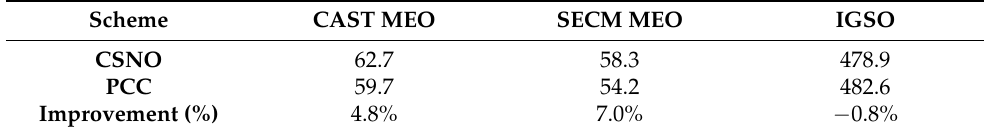
Figure 12. The time series of the differences of the CSNO Scheme IGSO orbit compared with the WUM products in along-track (A), cross-track (C), radial (R), and 3D RMS. It is well known that the vertical PCO and PCV have a significant influence on the PPP solutions, especially in the up direction (U) [24]. We carry out a BDS-only PPP com- parison to further study the quality of the proposed vertical PCO and PCV, 45 MGEX stations, which can track the B1C/B2a signals selected and marked as blue triangles in Figure 2. The orbit and clock products generated by the corresponding POD scheme are used for the PPP process, and 30 days of data from DOY 120, 2022, to DOY 149, 2022, is processed. The IGS weekly solution is selected as a reference. Figure 13 demonstrates the U-direction RMS of each station, for most stations, the PCC Scheme solutions have a clear advantage. The mean RMS of the north (N), east (E), and U directions are listed in Table 7, compared with the CSNO scheme, the accuracy of the PCC Scheme improved by 30.0%, 27.2%, and 31.1% for N, E, and U directions, respectively. Figure 13. The station U-direction RMS for BDS-only PPP solutions of CSNO and PCC Schemes. Table 7. BDS-only PPP RMS of each scheme and their comparison, the unit is mm. Scheme